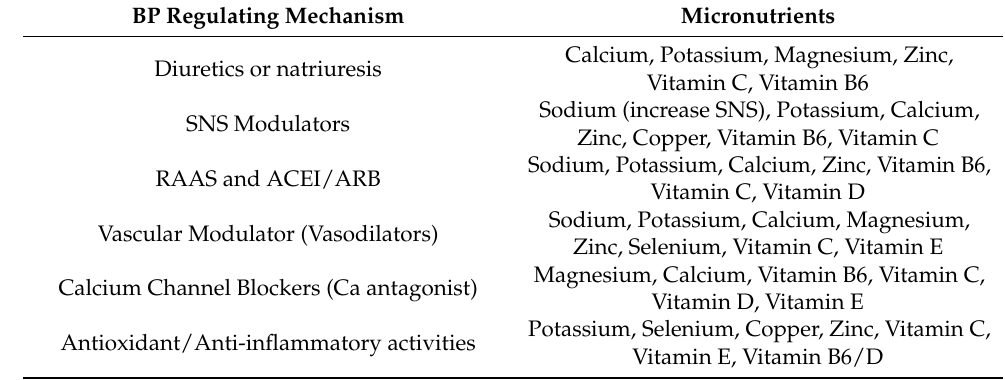
Table 2. The summary of possible BP regulating mechanism of various